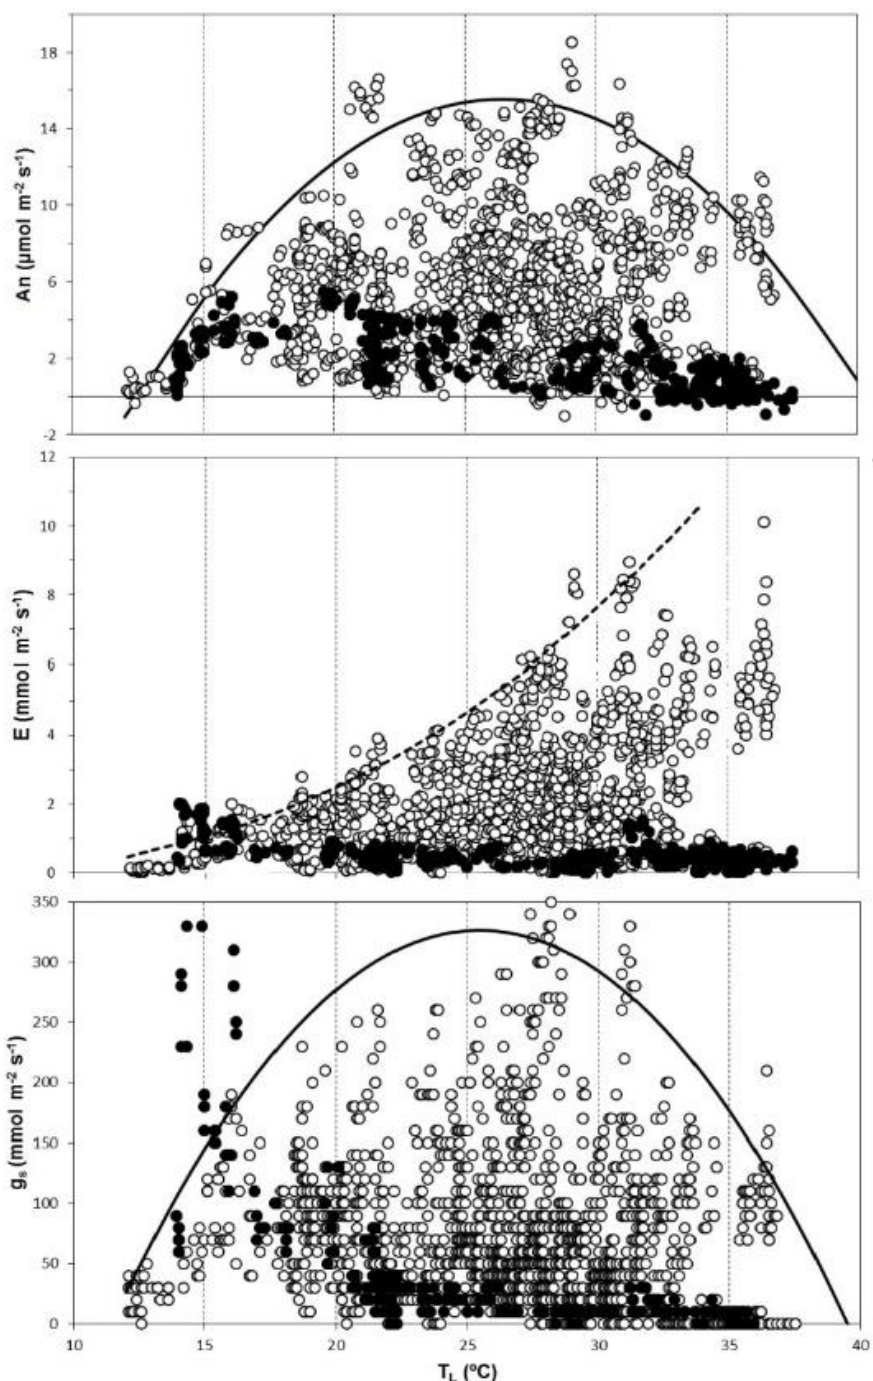
Figure 2. Regression analysis between leaf temperature (T L ) and net CO 2 assimilation rates (An: Top), transpiration rates (E: middle) and stomatal conductance (g s : Bottom) using boundary lines including 99 % of data points. Individual measurements were collected from March to April. Data showed in black are from the summer period. Regression for entire data set: An = -0.080* T L2 + 4.224 * T L − 40.268; E = − 0.275 + 0.0012T L0.01 ; g s = − 1.65 T L 2 + 84.26 T L − 747.03, all P < 0.000.